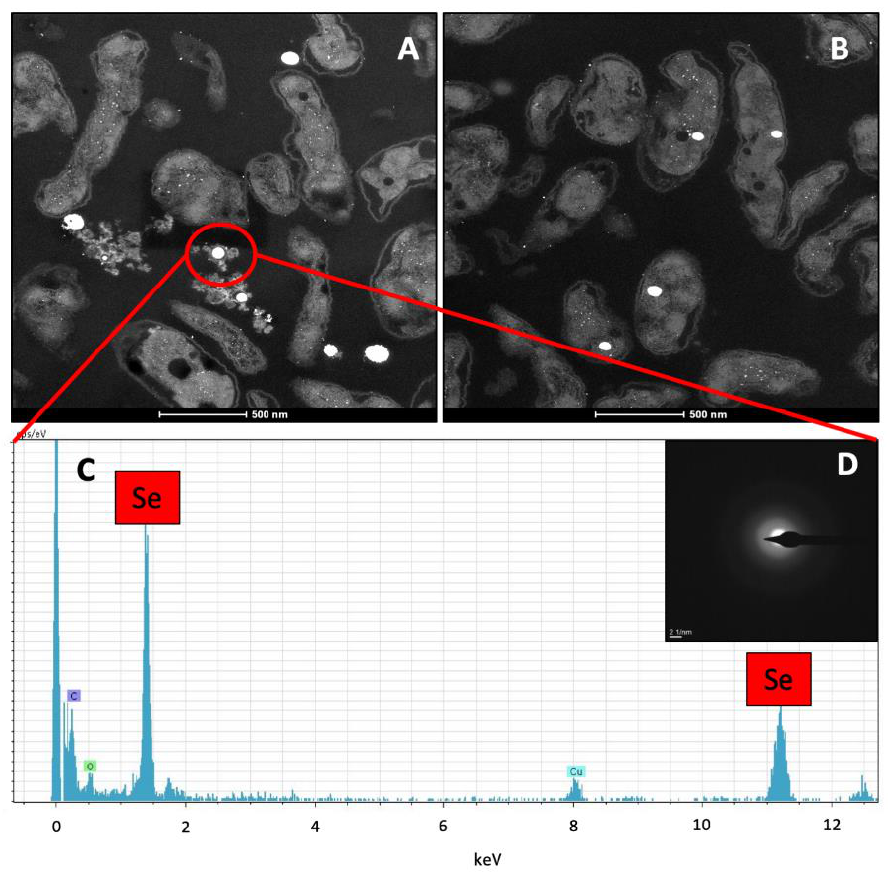
Figure 5. HAADF-STEM analysis of an ultrathin-sectioned S. bentonitica sample incubated anaerobically at a neutral pH in the presence of 2 mM Se IV ( A , B ). EDX analysis revealed the Se composition of the electron-dense nanospheres ( C ) located both intracellular and extracellularly ( A , B ). SAED pattern derived from an individual Se granule ( D ). Scale bars: 500 nm ( A , B ).